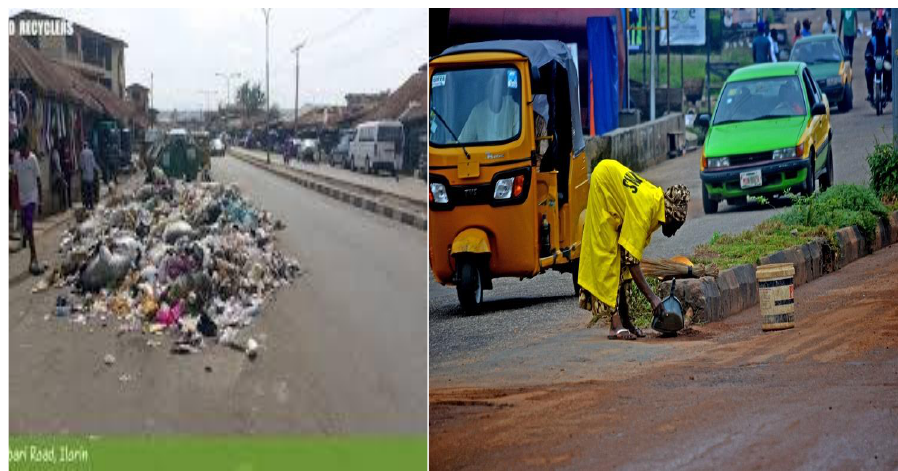
Fig. 1: The littered street and the Cleaning Agent at Work in the city of Ilorin